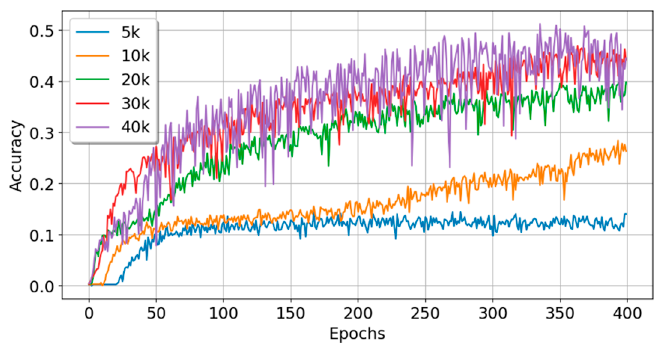
Figure 23. The performance of RNN for different size data.